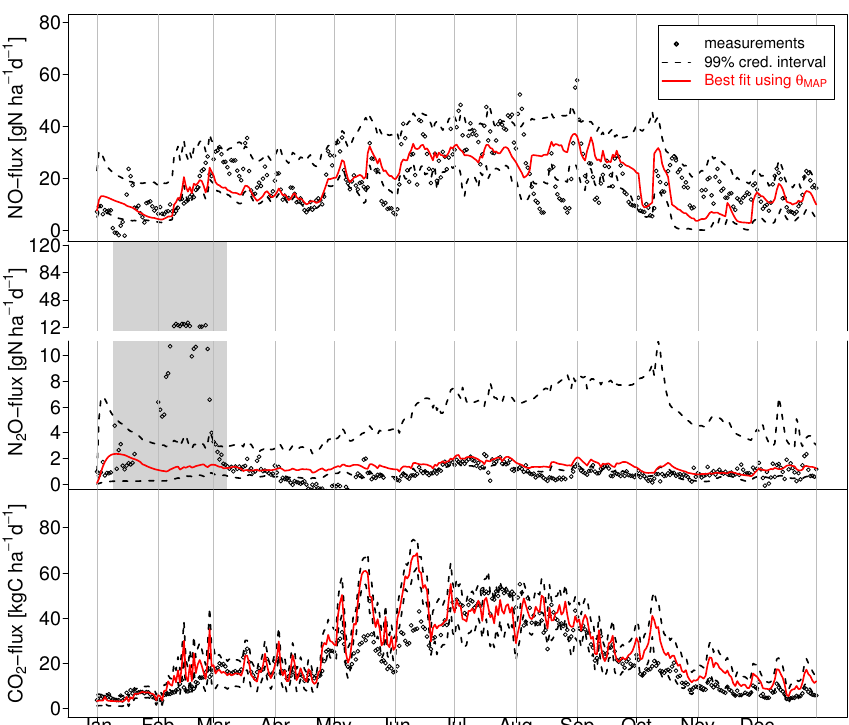
Fig. 5. Simulated fluxes (calibration set) versus measurements of NO, N 2 O and CO 2 fluxes at the spruce site of the H¨oglwald forest in the year 1997. The grey box highlights pulse emissions of N 2 O during soil freeze-thaw